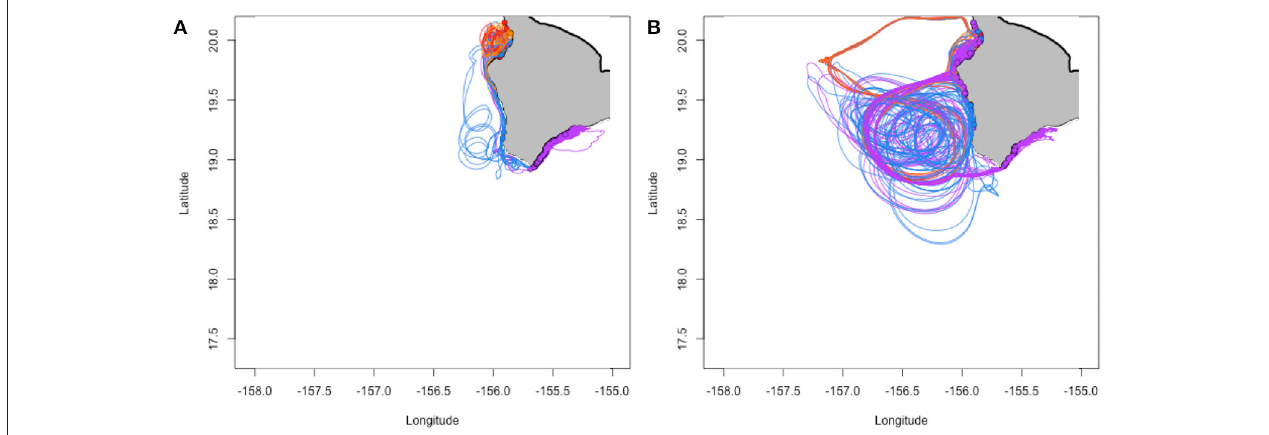
FIGURE 2 | Example trajectories for successfully settling individuals in February ( A ; 962 individuals) and May ( B ; 215 individuals) of 2012. Colors correspond to spawning locations in Figure 1B , Table S1.